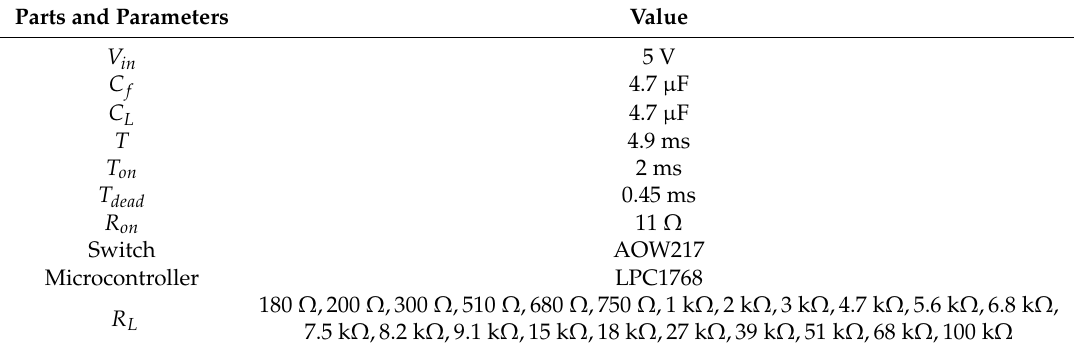
Figure 9. Experimental test. Table 3. Circuit parts and parameters for